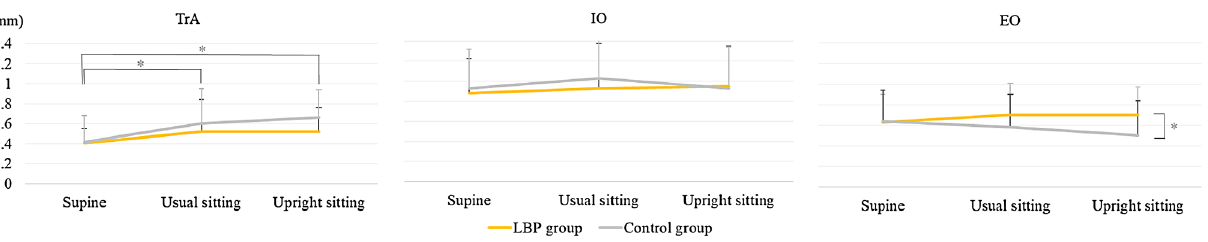
Figure 2. Thickness of the transverse abdominis, external oblique, and internal oblique muscles in the ( A ) supine, ( B ) usual sitting, and ( C ) upright sitting positions, in groups with and without lower back pain.